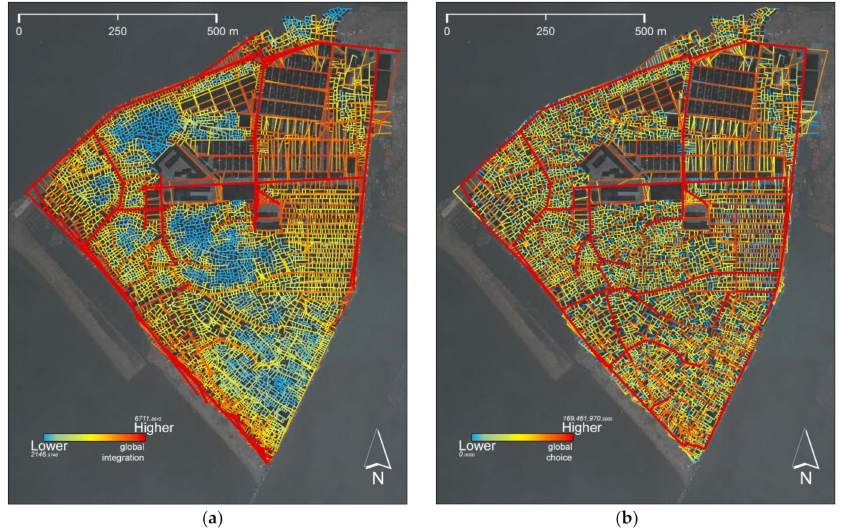
Figure 3. Configurational analysis of the BaSECo informal settlement: ( a ) global integration index; ( b ) global choice. Values vary from blue (lower) to red (higher). Widest red lines highlight the 20-quantile of higher values. Closed spaces are filled with black, solid hatch.